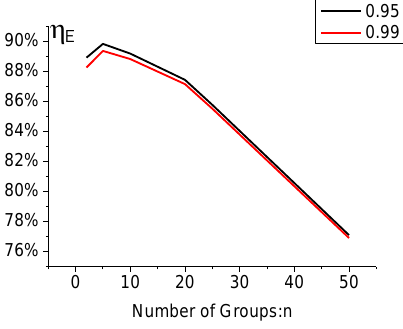
Figure 10. Relationship between η E and the number of groups.